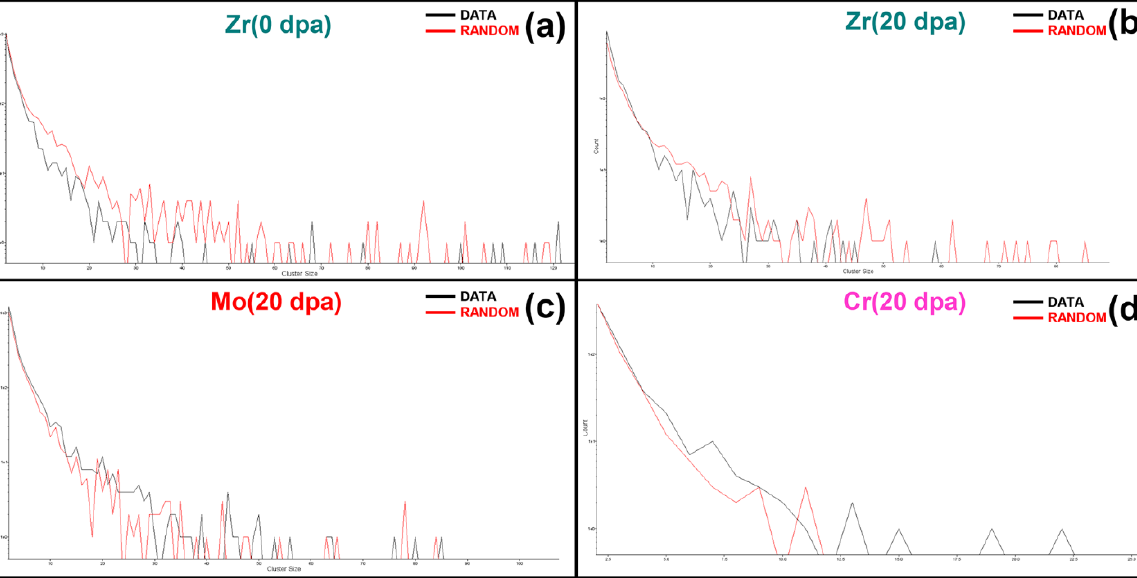
Figure A2. Size distribution analyses of ( a ) Zr at 0 dpa, ( b ) Zr at 20 dpa, ( c ) Mo at 20 dpa, and ( d ) Cr at 20 dpa.